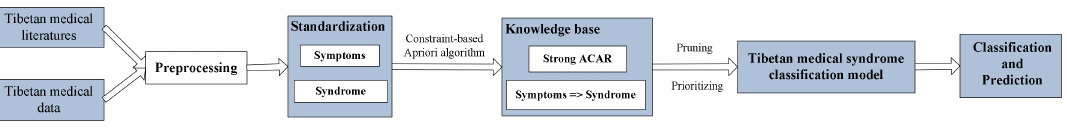
Figure 2. Flow diagram of classification model of the Tibetan medical